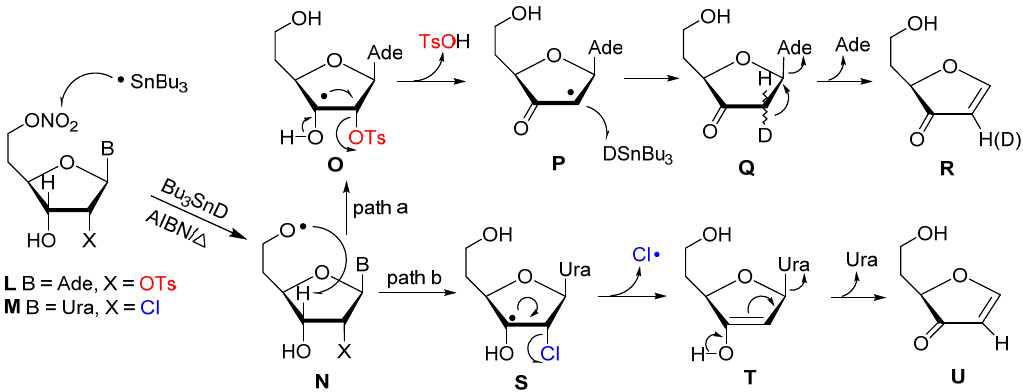
Figure 4. Heterolytic (path a, TsO − ) and homolytic (path b, Cl • ) eliminations from radicals containing a 3’-hydroxyl group [21,29,30].